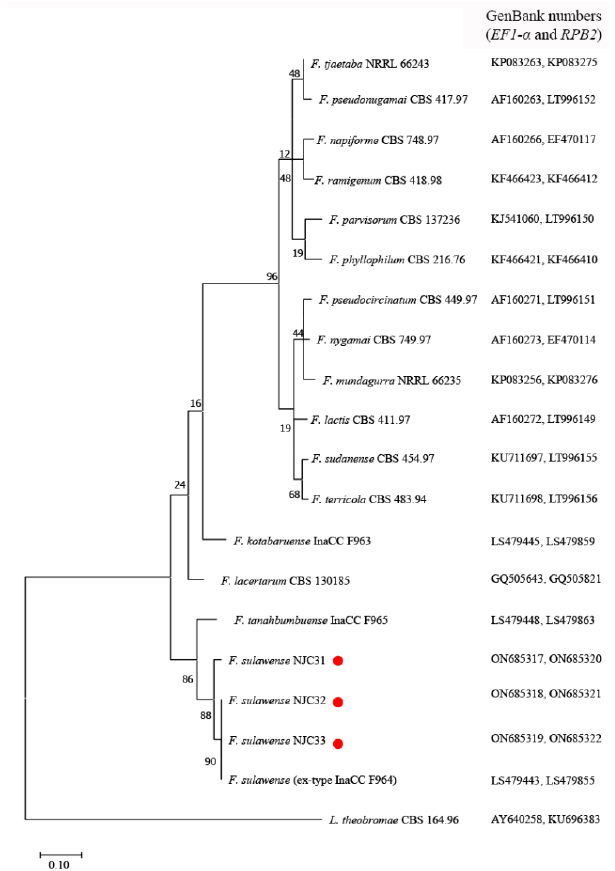
Figure 3. Phylogenetic analysis of elongation factor 1- α ( EF1- α ) and RNA polymerase II second largest subunit ( RPB2 ) sequences from Fusarium sulawense strains NJC31, NJC32 and NJC33. The tree